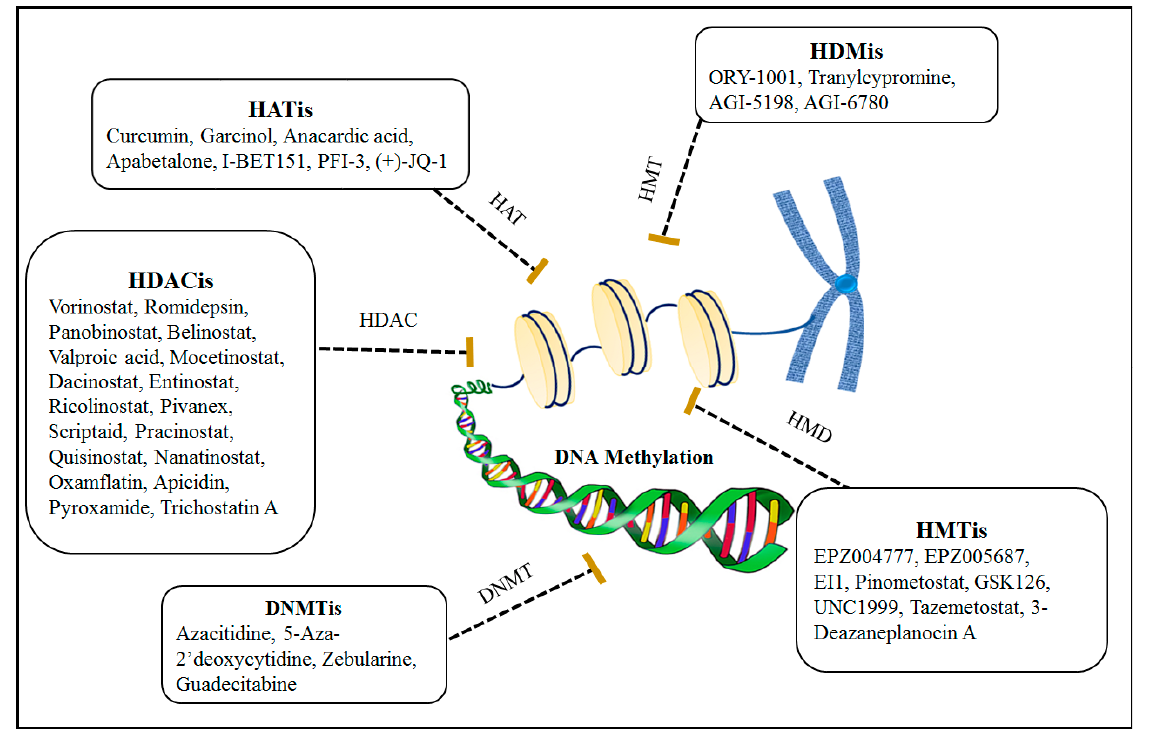
Figure 4. The schematic fi gure shows the epigenetic drugs used to inhibit the main four classes of enzymes in epigenetic therapy: DNMTi, HMTis, HDMis, HATi, and HDACi. Table 1. Epigenetic drugs to inhibit DNMT, which contains information about the name of drug/al- ternate name, formula, and applicable in treatment of various diseases, and whether they are ap- proved by the FDA or